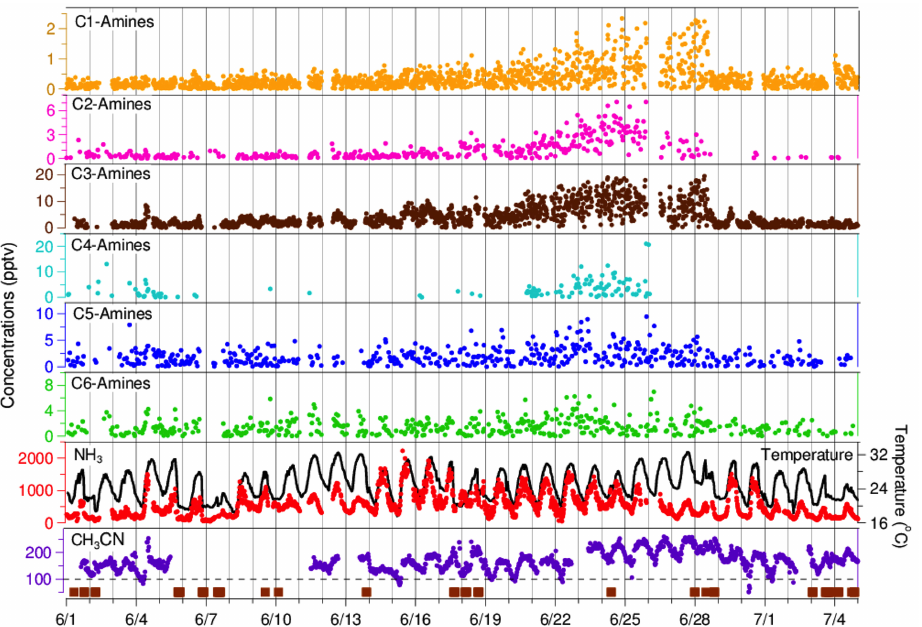
Figure 2. Temporal variations of amines, NH 3 , and CH 3 CN along with the ambient temperature measured in the Alabama forest during the entire SOAS field campaign. Vertical grids correspond to times at midnight. The brown colored bars in the bottom panel indicate the period of rainfalls. Concentrations of amines and NH 3 data shown here were averaged over 20min; the same for Figs. 3, 8 and